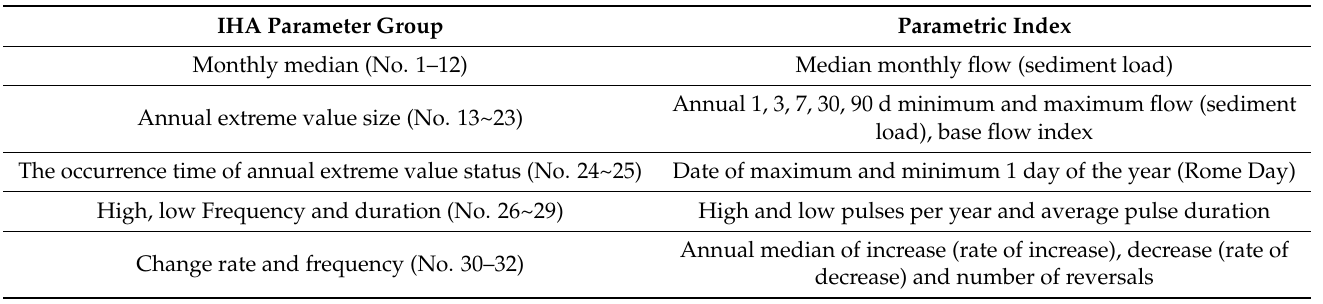
Table 1. Indexes of